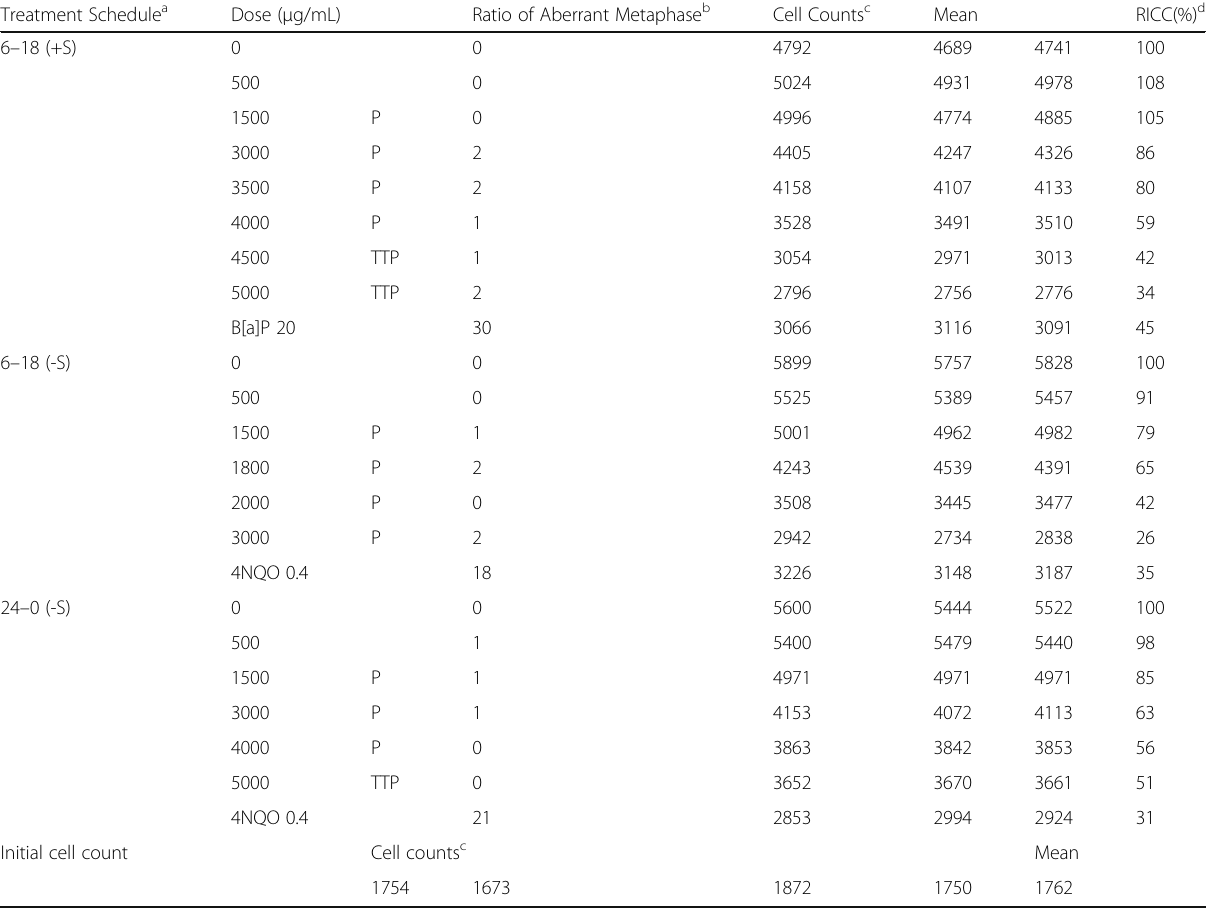
a Treatment time – Recovery time in the presence (+S) and absence (-S) of metabolic activation system b Ratio of metaphase with chromosome aberrations. One culture/ dose was used Gaps excludes, 100 metaphases/ culture were examined c After harvesting mitotic cells, each culture was trypsinized and suspended with 0.5mL of 0.1% trypsin and 5mL of culture medium The cell suspensions of 0.4mL per culture were diluted 50 times with 19.6mL of Isoton sol. The cells in 0.5mL Isoton sol. were counted twice/ culture using Coulter Counter model Z2 T: Turbidity at the end of the treatment P: Precipitation at the end of the